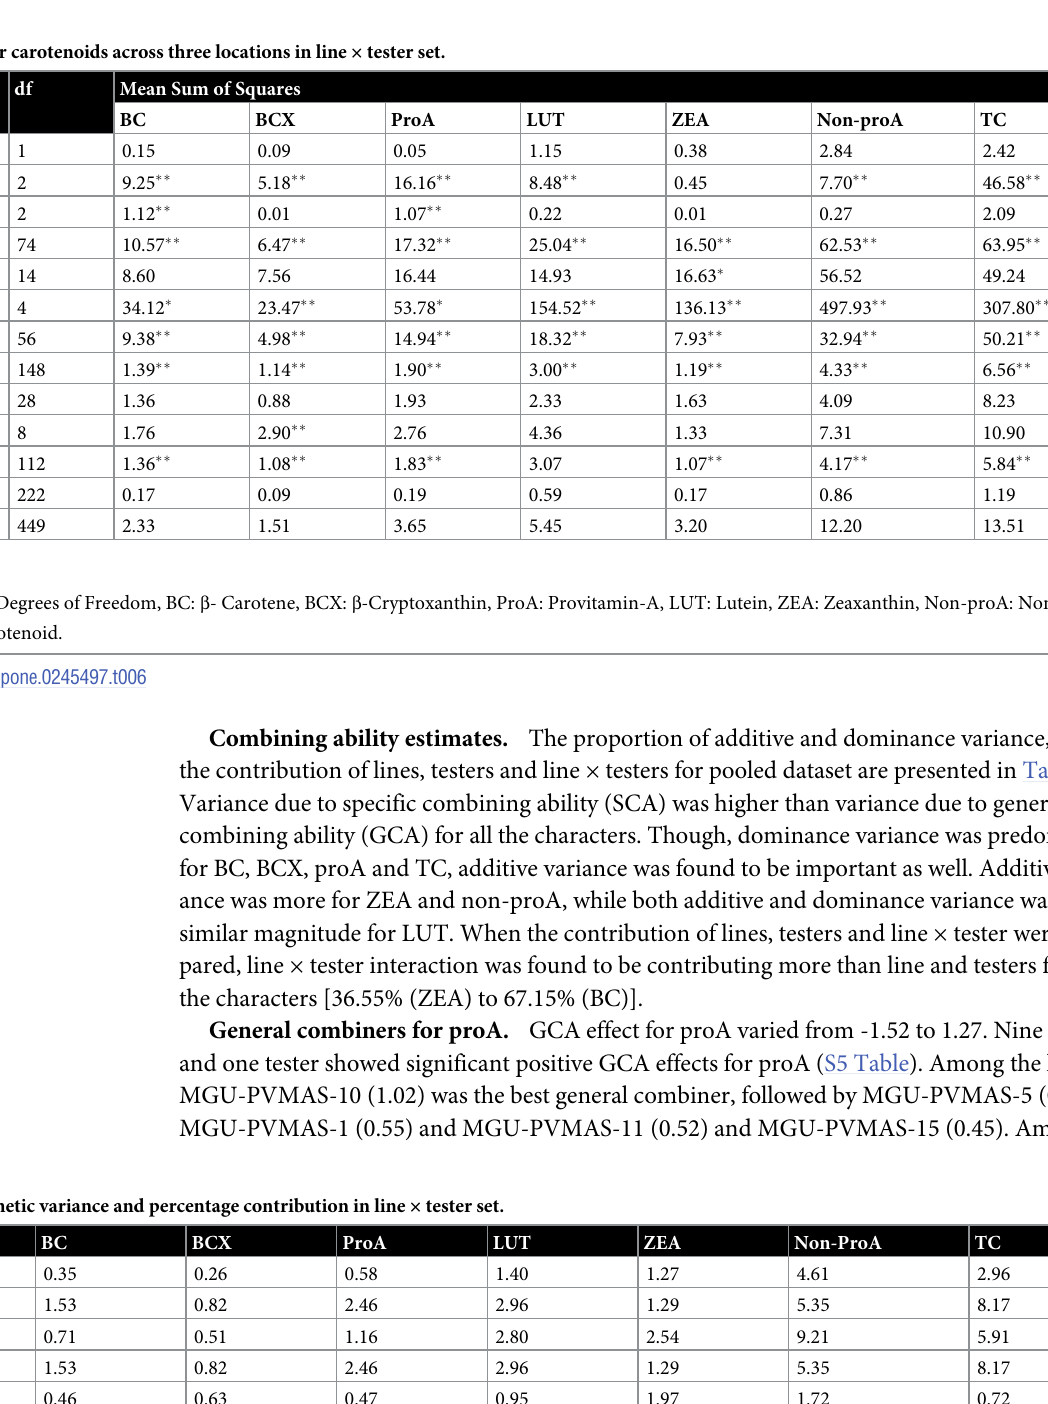
Table 6. Pooled ANOVA for carotenoids across three locations in line × tester set. Source of Variations